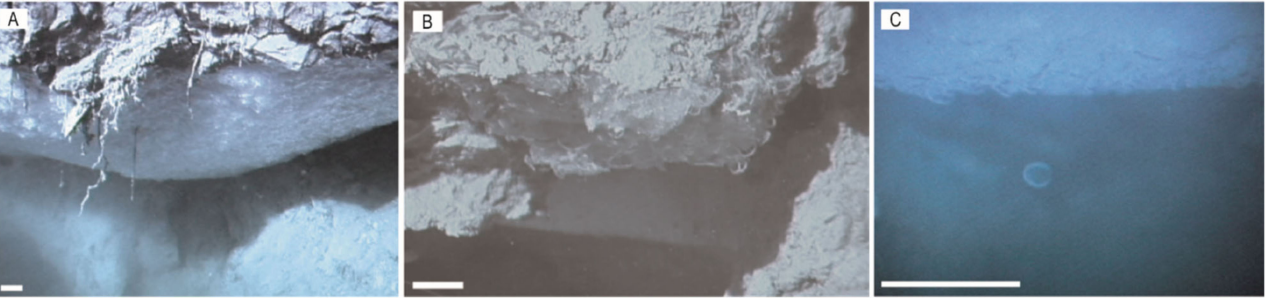
Figure 18. Massive layered gas hydrate outcrops at the ODP Site 996 on the crest of the Blake Ridge Diapir. ( A ) Hydrate chunks trapped beneath a sediment-coated carbonate cap; ( B ) close-up of hydrate-enveloped bubbles; and ( C ) ascending hydrate-coated bubble to be trapped by the overlying carbonate (cited from